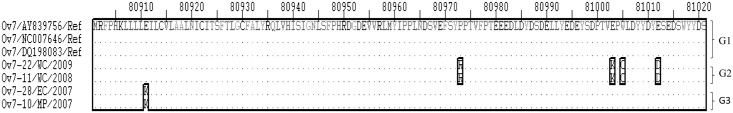
Multiple sequence alignment of amino sequences of the Ov 7 gene from SA OvHV-2 strains and reference sequences derived from OvHV-2 genome sequences (Accession number: NC-007646.1, AY839756.1, DQ198083.1) analysed with ExPASy translate tool.Ref on the alignment indicates the amino acid sequences of the Ov 7 gene of the OvHV-2 reference genomes obtained from the GenBank. Variable regions are highlighted in rectangles (▯) and groups of amino acid sequences (G) are illustrated on the right side of the align sequences.